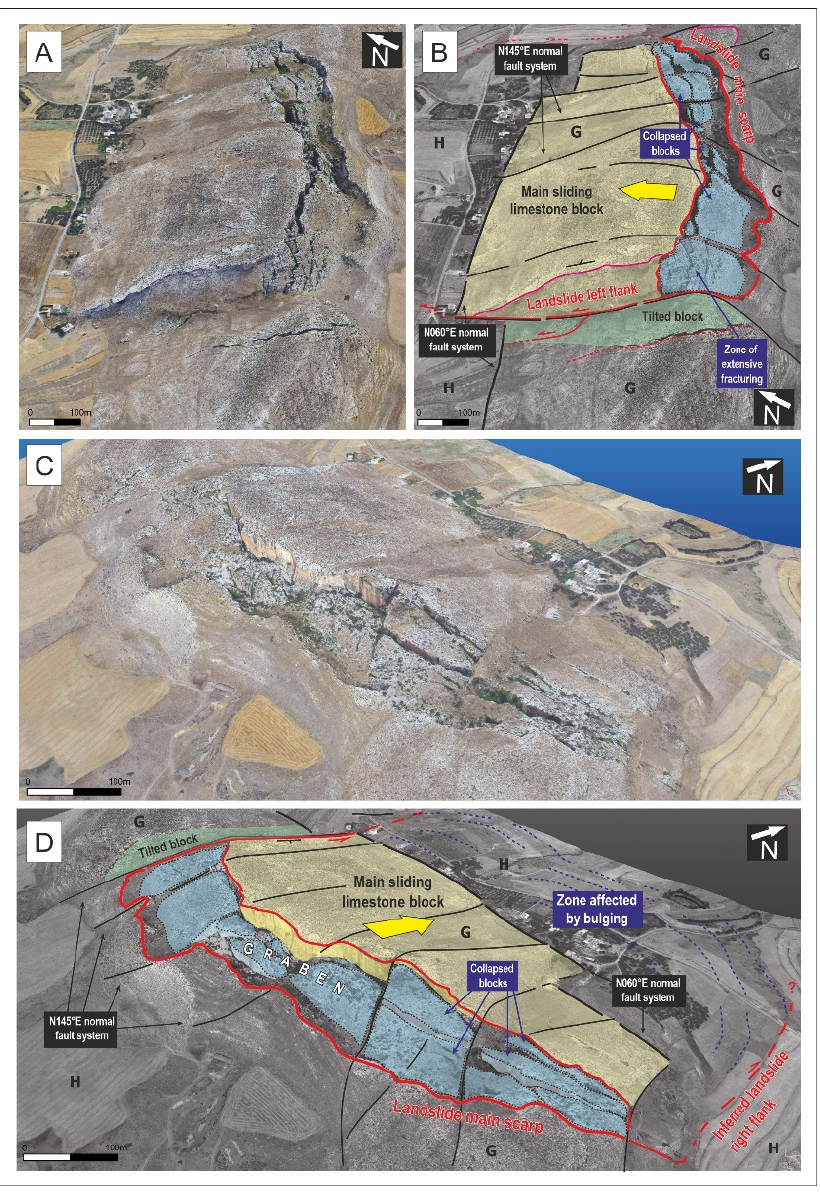
Figure 8. Virtual oblique aerial views of Chgega landslide from the Southwest ( A , B ) and from the East ( C , D ). The main morphological features of the complex landslide and the geological structures are highlighted in B and D. G : Garia Formation; H: Haria Formation. The views were generated using the 3D model produced by means of SfM methods. The lateral movement of the limestone block produces a graben in the upper part of the relief. The graben forms a closed depression ~800 m long and ~120 m wide; its maxi- mum depth is estimated to coincide with the Garia Formation thickness (~60 m [30]) (Fig- ures 8 and 9B,C). The elongation of the graben follows a N060°E direction and has a slightly curved geometry. Its boundary in the NW sector is sharp, coinciding with the limits of the limestone block. A scarp—neither clear nor regular—limits the other side of